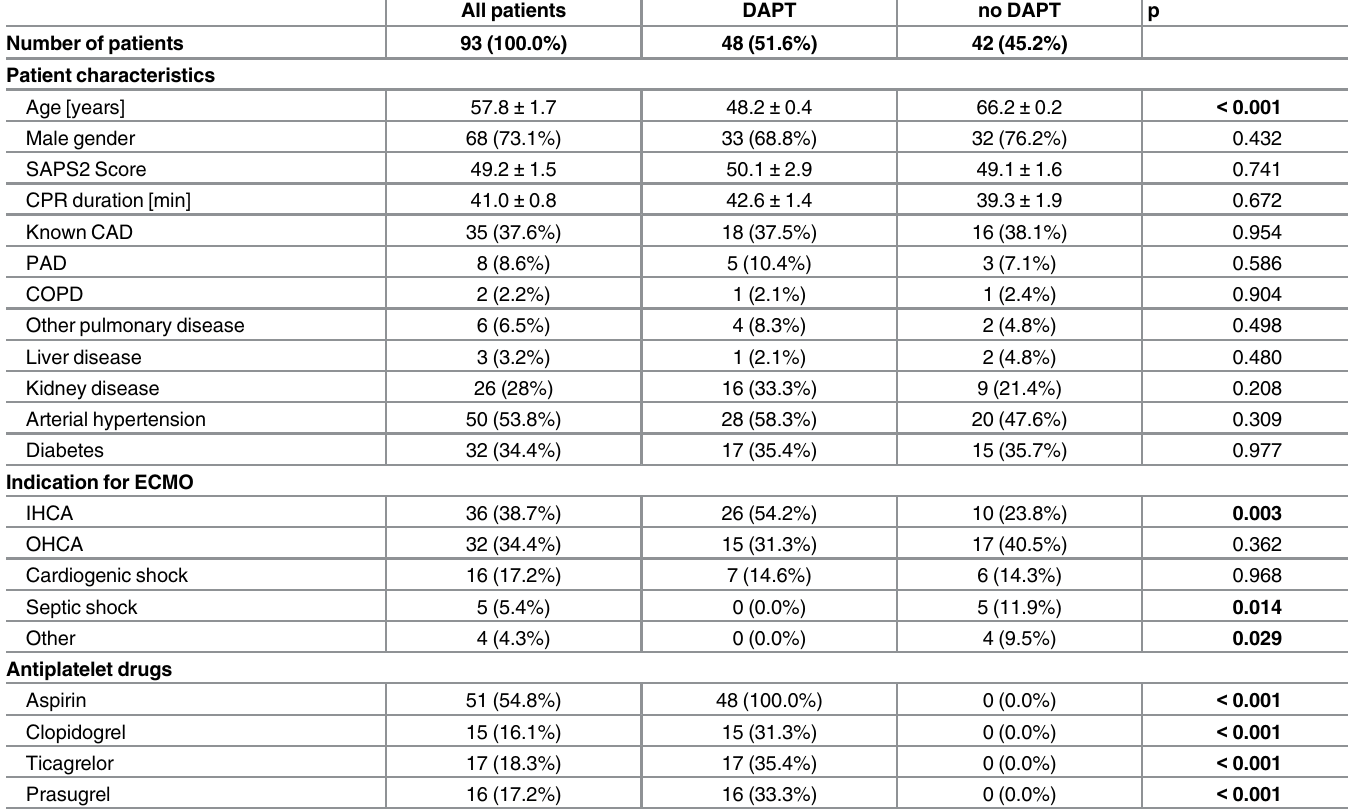
Table 1. Patients ’ characteristics.